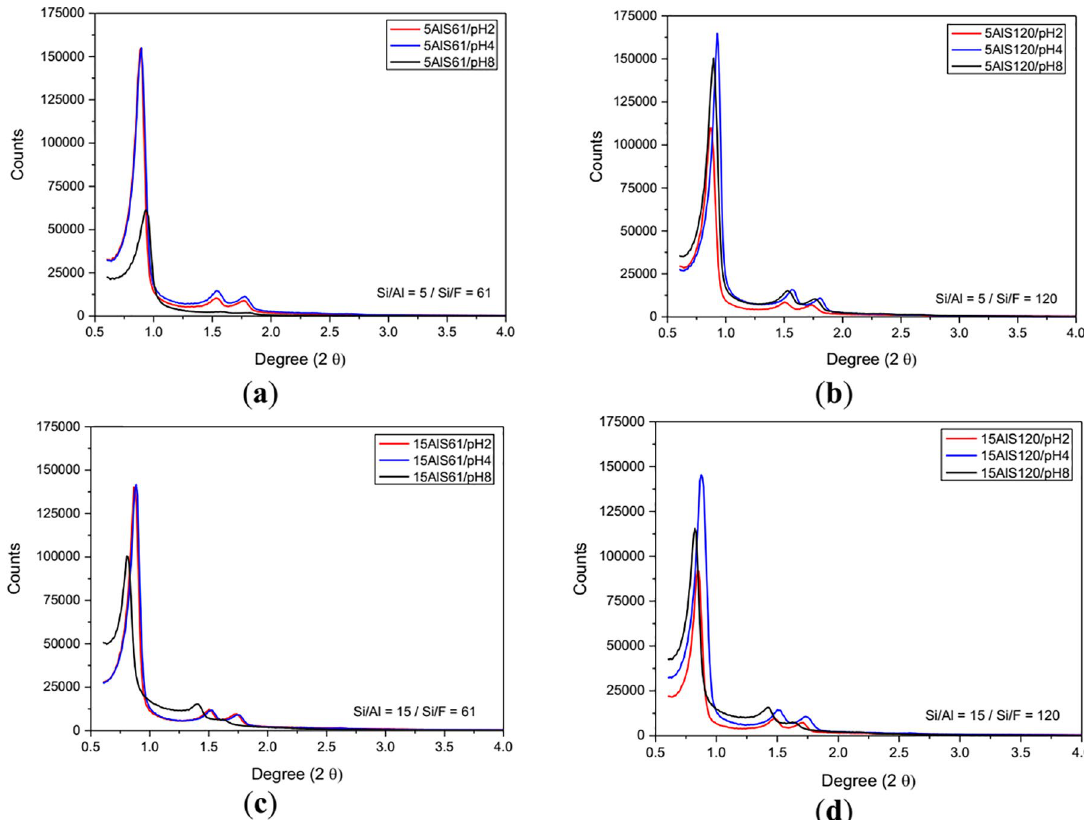
Figure 2. Diffractograms of the calcined samples synthesized by pH adjustment. Samples are divided based on the ratios of Si/Al and Si/F: (a) Samples synthesized with Si/Al = 5 and Si/F = 61; (b) Samples synthesized with Si/Al = 5 and Si/F = 120; (c) Samples synthesized with Si/Al = 15 and Si/F = 61; (d) Samples synthesized with Si/Al = 15 and Si/F =